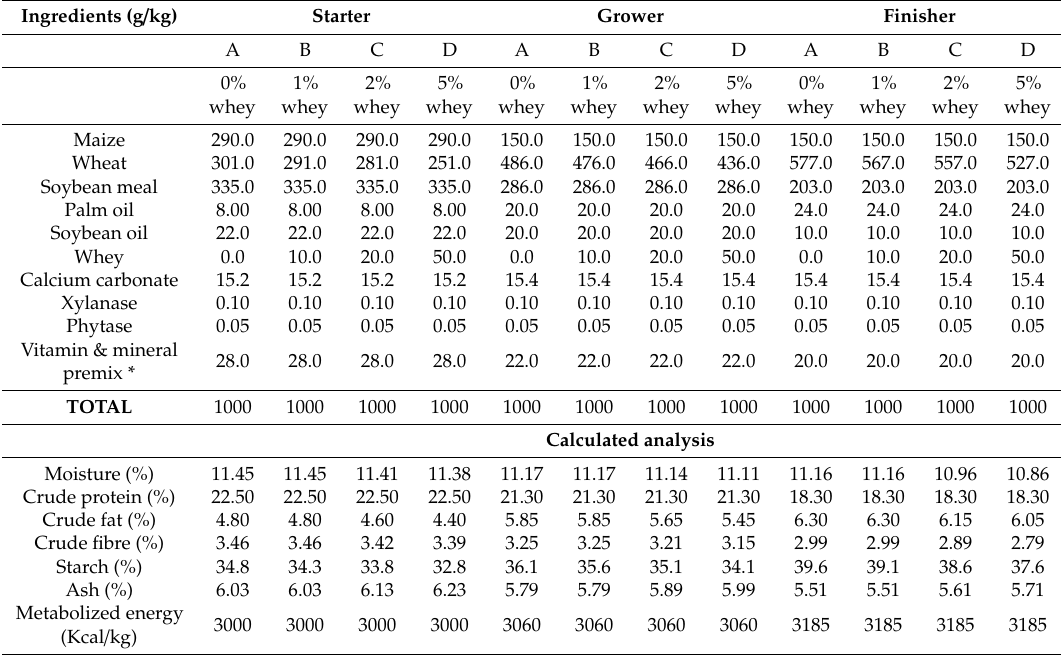
Table 1. Composition and chemical analysis of the basal poultry diets used in the experiment. Ingredients (g /